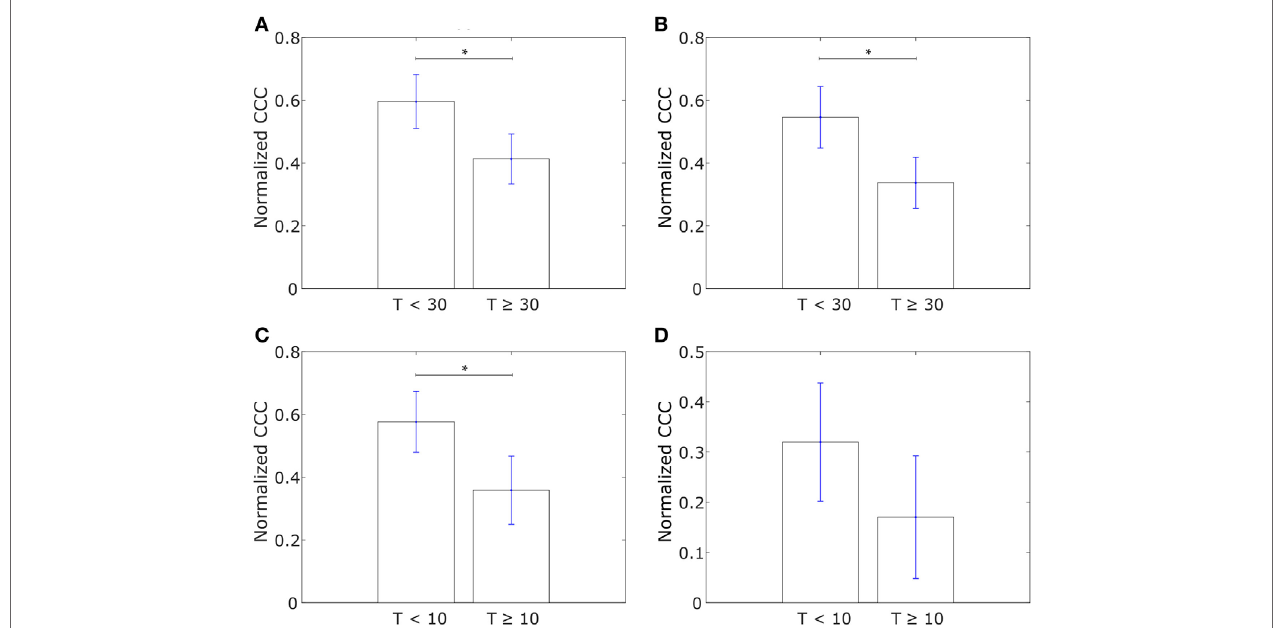
FigUre 6 | (a) Normalized cophenetic correlation coefficient of the collective dissemination-associated gene network for breast cancer patients with metastatic relapse within a 30-month period posttreatment ( T < 30; n = 56) or between 30 and 60 months posttreatment ( T ≥ 30; n = 51). Gene expression data from the study by Wang et al. (53). (B) Normalized CCC of the inflammatory breast cancer-associated gene network for the same groups of breast cancer patients as in (a) . (c) Normalized CCC of the collective dissemination-associated gene network for small cell lung cancer (SCLC) patients with less than 10 months of disease-free survival posttreatment ( T < 10; n = 11) and SCLC patients with longer than 10 months of disease-free survival posttreatment but death during the follow-up period ( T ≥ 10; n = 10). Gene expression data from the study by Rousseaux et al. (54). (D) Normalized CCC of the IBC-associated gene network for the same SCLC patient groups as in (c) . Error bars indicate the SE in the estimate of CCC norm calculated using the bootstrap method. * p -Value <